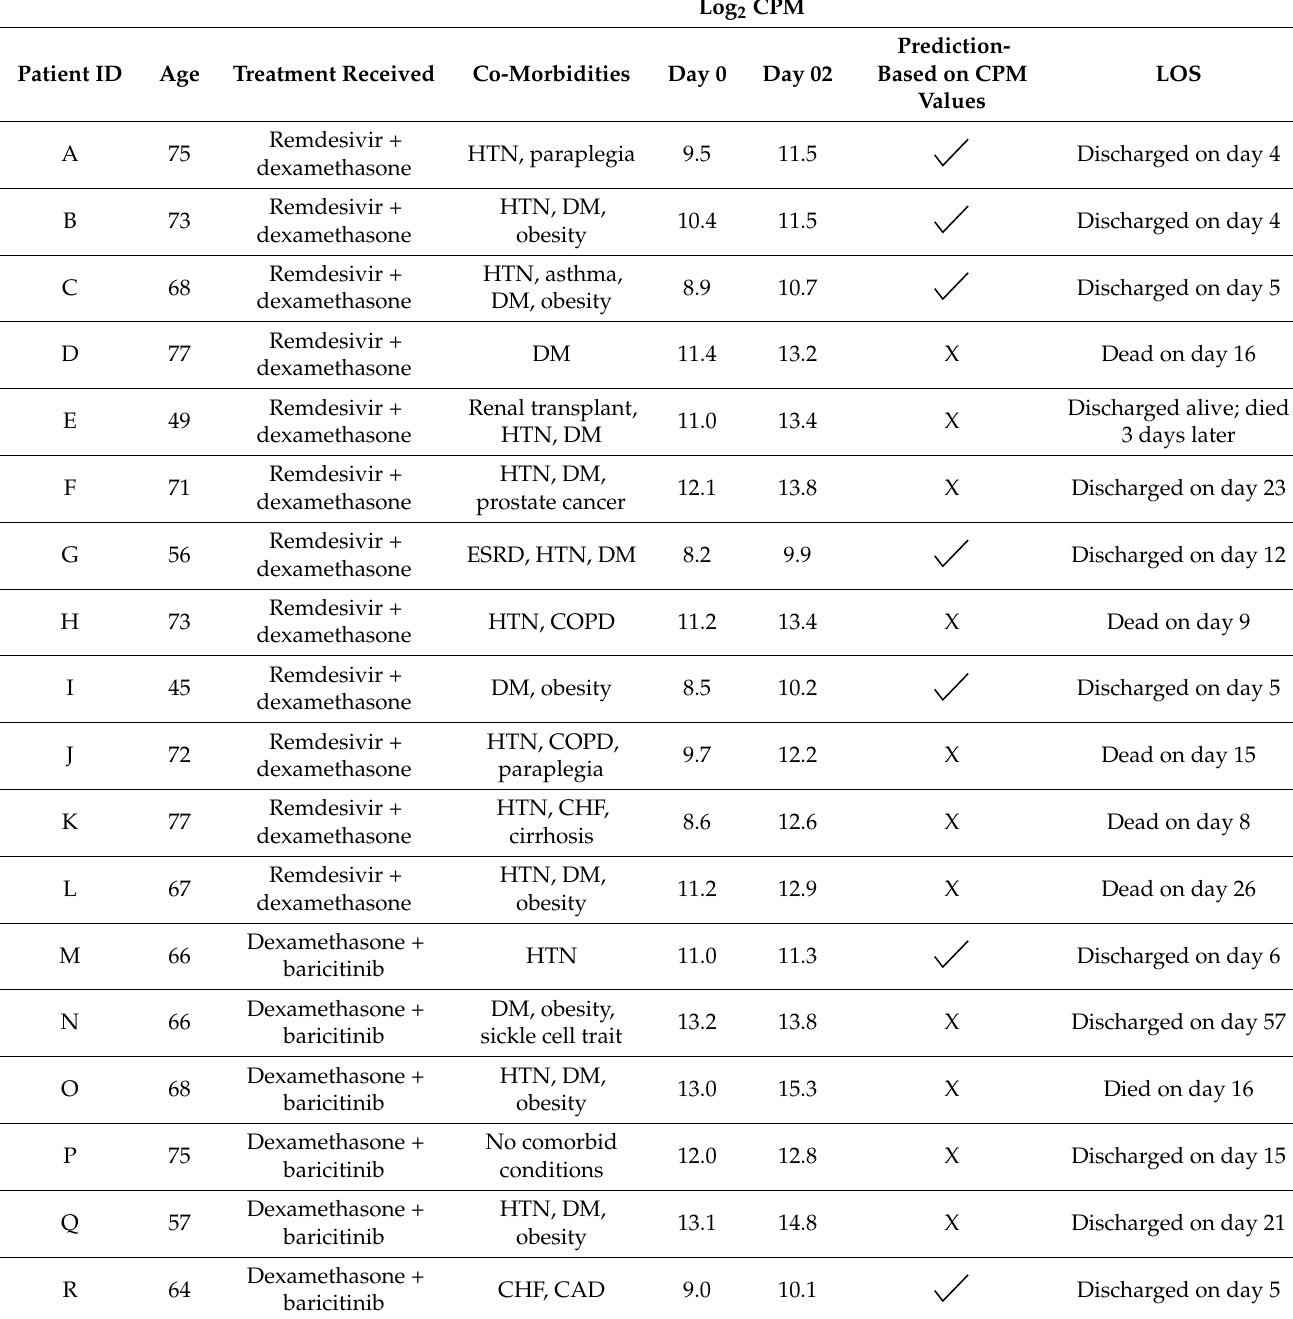
Table 1. Our predictions based on expression values for miR-6741-5p.